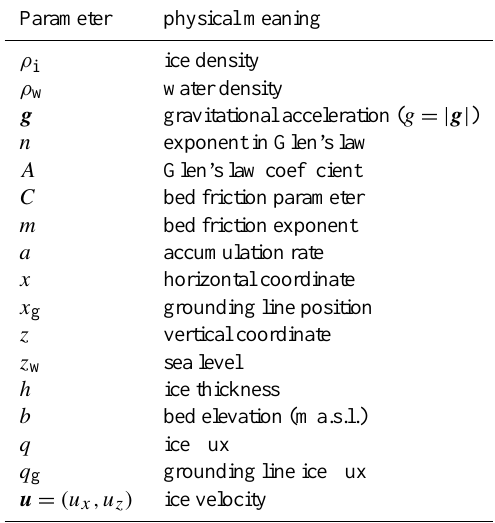
Table 1. List of parameters prescribed for the experiments, as well as other